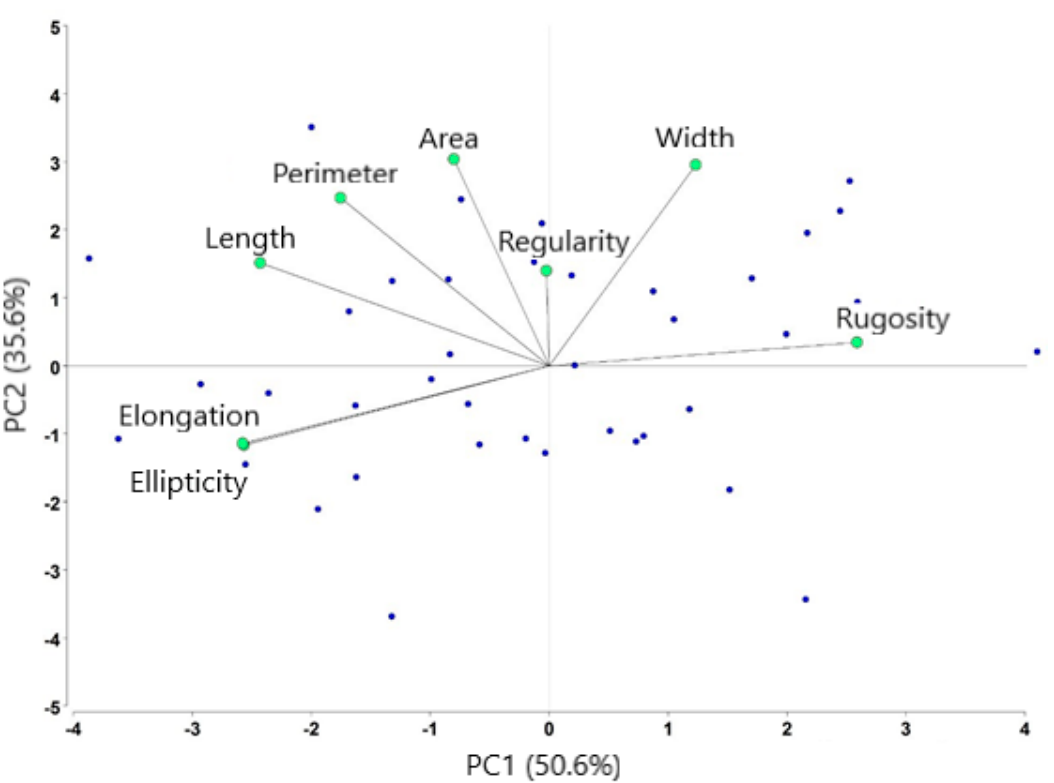
Figure 3. Distribution of morphometric variables after principal component analysis. Each blue point represents an ejaculate. Four sperm sub-population were identified from forty ejaculates. Table 3. Eigenvectors of principal components (PCs) * for the morphometric variables of boar sperm size and head shape.